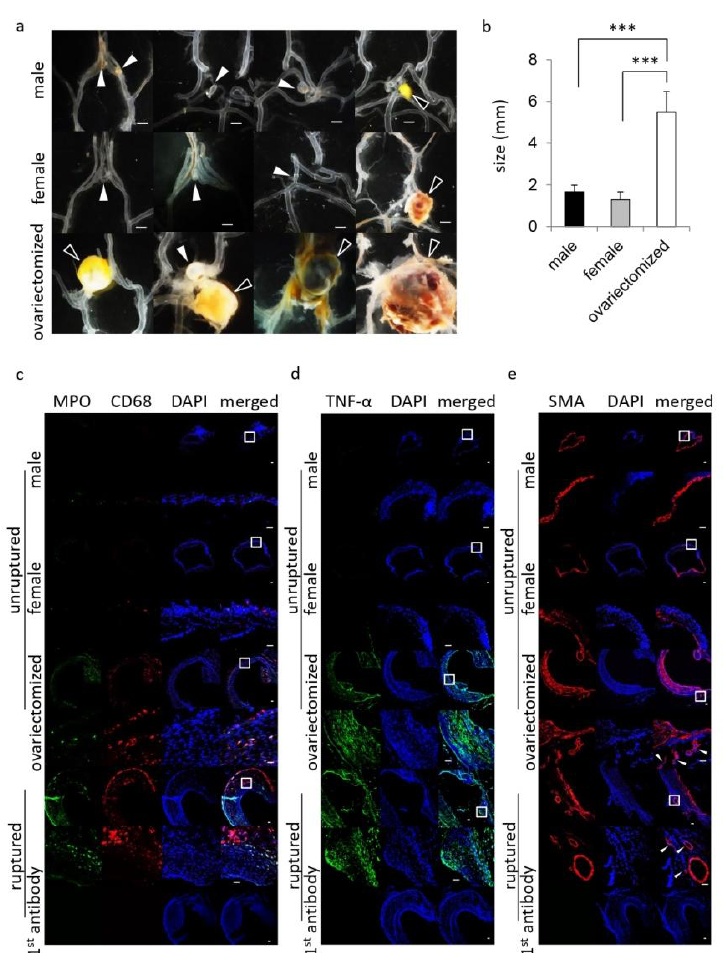
Figure 2. The exacerbation of the pathology of intracranial aneurysm in female rats with the bilateral ovariectomy. Ten-week-old female Sprague−Dawley rats were subjected to the aneurysm model. At 120 days after the surgical manipulations, specimens of induced lesions were harvested. ( a , b ) The macroscopic image of induced lesions ( a ) and their size ( b ) in each group; male rats ( n = 18), female rats without ovariectomy (female, n = 10) or female rats with the bilateral ovariectomy (ovariectomized, n = 10). Bar, 1.0 mm ( a ). The white arrows and the black ones in ( a ) indicate the unruptured and the ruptured lesions, respectively. Bars in ( b ) indicate the mean ± SEM. Statistical analysis was done by the Tukey–Kramer method. ***; p < 0.001. ( c , d ) show similarity of unruptured lesions induced in female animals with the bilateral ovariectomy with ruptured ones. The representative images of immunostaining for a marker for neutrophil, myeloperoxidase (MPO, green in ( c )), a marker for macrophage, CD68 (red in ( c )), TNF- α (green in ( d )), a marker for smooth muscle cell, smooth muscle alpha-actin (SMA, red in ( e )), nuclear staining by DAPI (blue) or merged images are shown. The immunostaining without a 1st antibody served as a negative control and the representative images of this staining are shown in the lowest panels. Ruptured lesions were from female rats with the bilateral ovariectomy. The arrow in ( e ) indicates vasa vasorum with SMA-positive media. The magnified images, corresponding to a square in the upper panels, are shown in the lower panels. Bar, 20 μm.